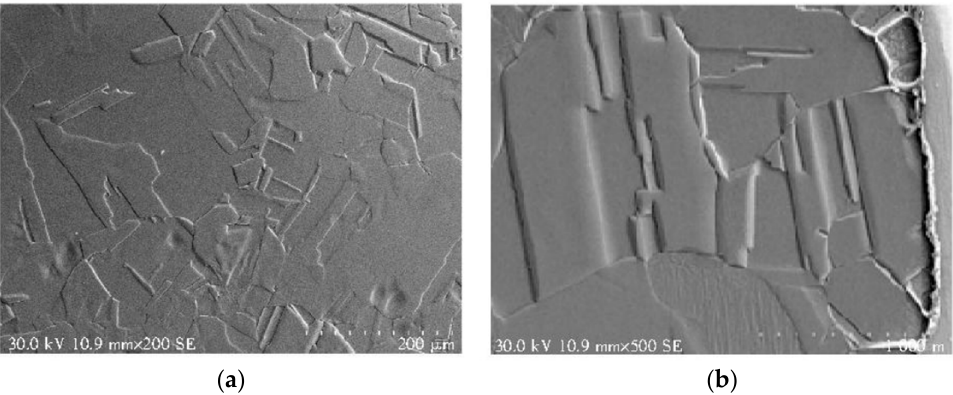
Figure 9. SEM image of cross section of Au-coated Ag wire, (a) the magnification is 200 times and (b) the magnification is 500 times [135]. Reproduced with permission from Ref. [135]; published by Semiconductor Technology, 2018.